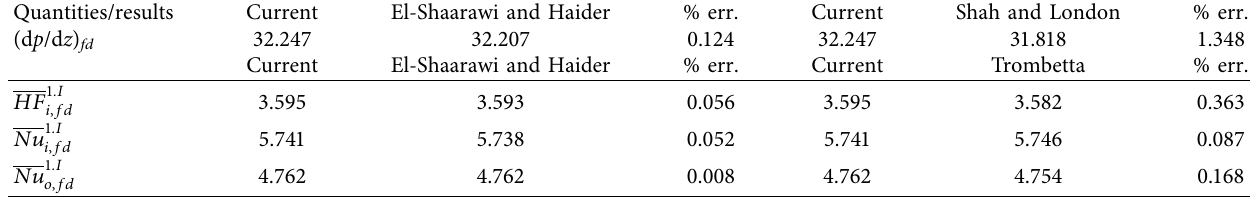
Table 3: Comparison with available conventional forced convection results for eccentric annular channel having linear axial increment,